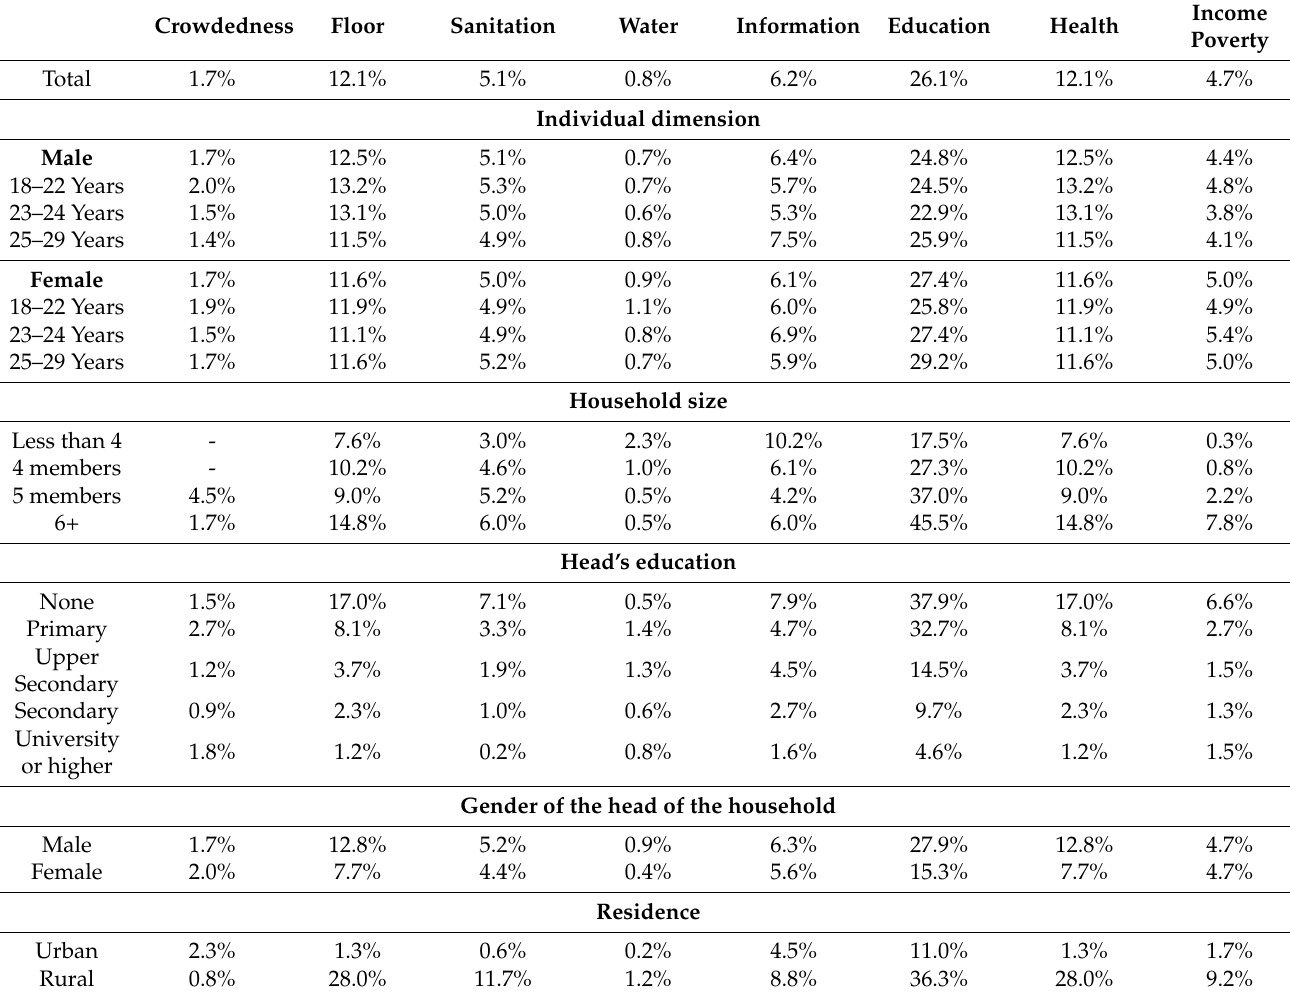
Table 5. Prevalence of all deprivation dimensions among youth 18–29 years by characteristics,